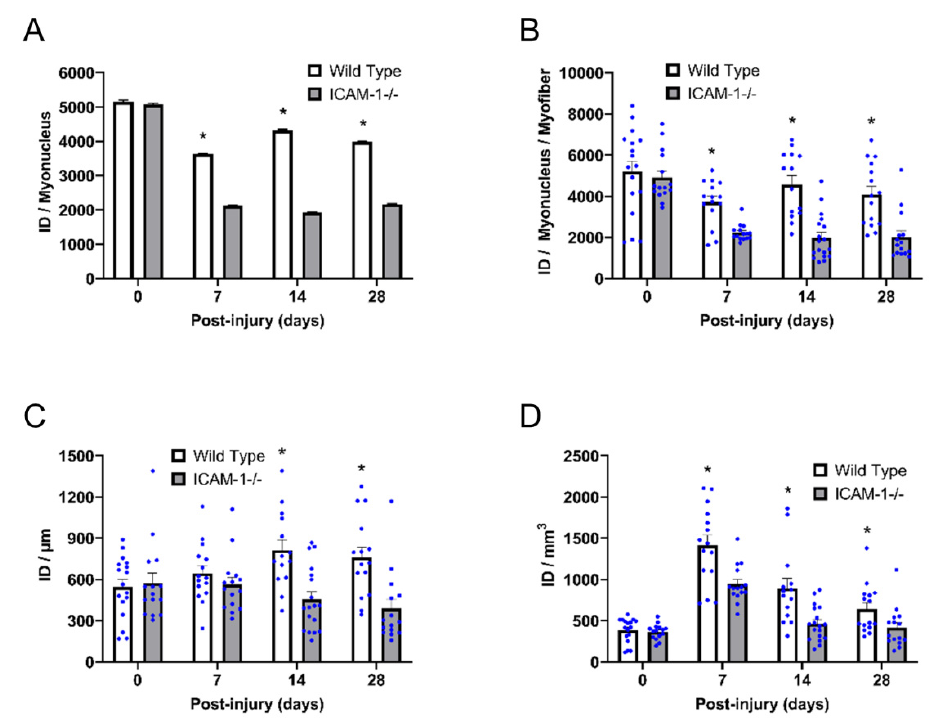
Figure 5. Transcriptional activity of individual myonuclei and myofibers before and during injury- induced muscle regeneration. An integrated density (ID) of EU was calculated for each myonucleus to represent its transcriptional activity, as described in the Methods. ( A ) Integrated density for all myonuclei within myofibers at 0, 7, 14, and 28 days post-injury ( n = 5310–13,057 myonuclei per time point/genotype). * = higher for Wild Type compared with ICAM-1-/- mice at indicated time point (interaction effect; p ≤ 0.001). ( B ) Integrated density for all myonuclei when averaged on a per myo- fiber basis ( n = 14–18 myofibers per time point/genotype. * = higher for Wild Type compared to ICAM-1-/- mice at indicated time point (interaction effect; p ≤ 0.001). ( C ) Integrated density per my- ofiber length (100 μ m) ( n = 14–18 myofibers per time point/genotype). * = higher for Wild Type compared with ICAM-1-/- mice at indicated time point (interaction effect; p = 0.003). ( D ) Integrated density per myofiber volume (mm 3 ) ( n = 14–18 myofibers per time point/genotype). * = higher for Wild Type compared with ICAM-1-/- mice at indicated time point (interaction effect; p = 0.009).